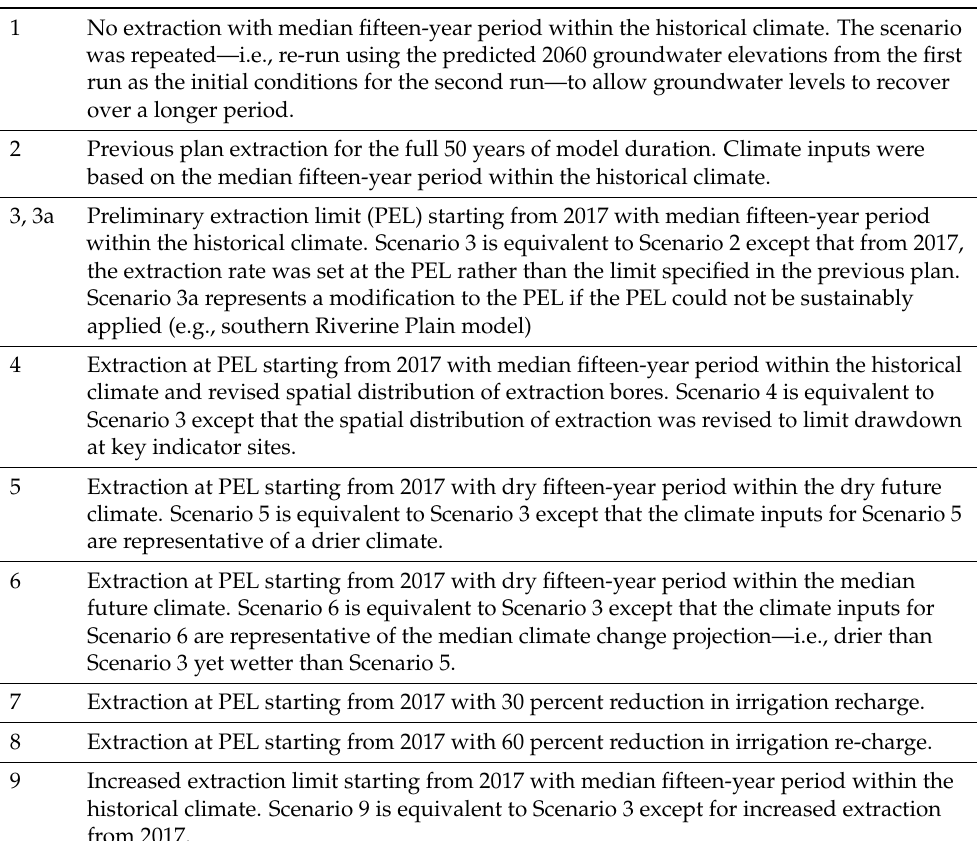
Table 2. Descriptions of the scenarios used in the modelling. Refer to the modelling reports for more details on the extraction limits used and the climate